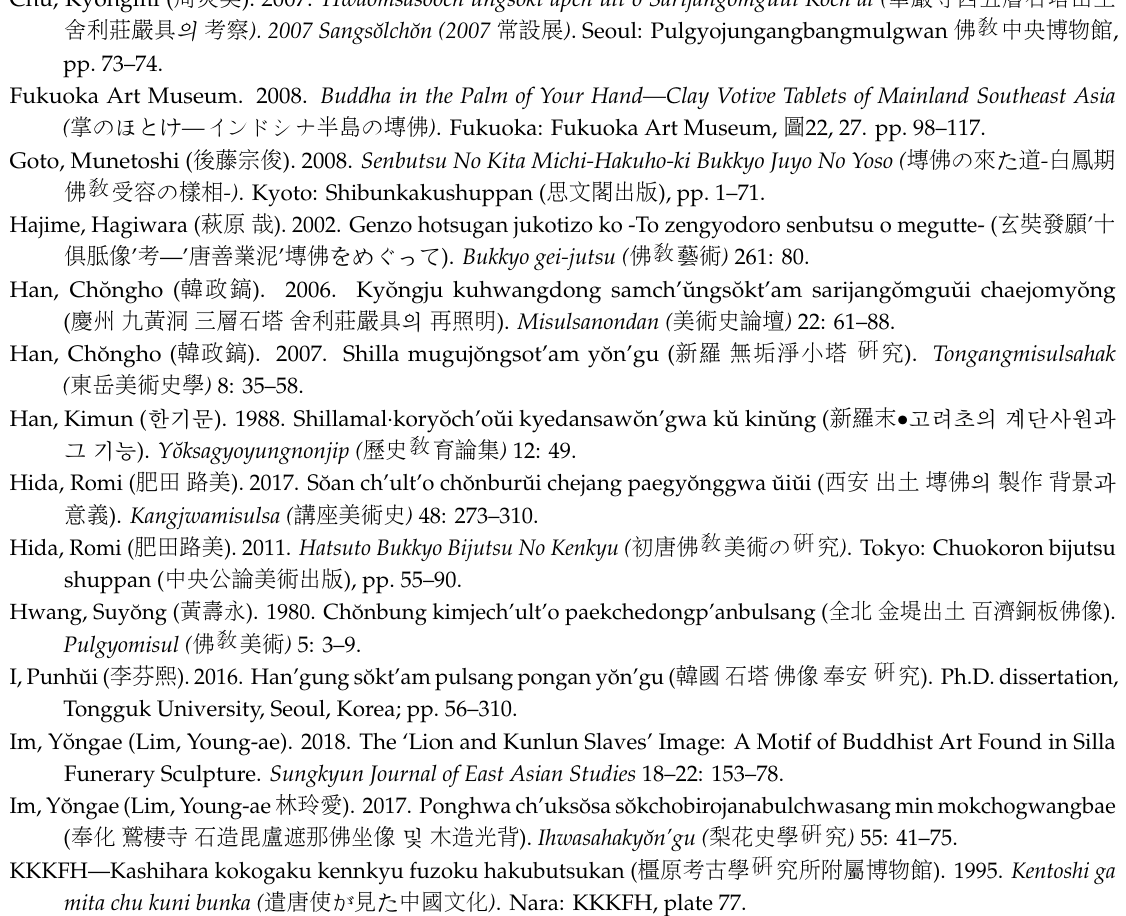
Figure 20. Clay Buddha, Pagan period, 12th–13th centuries, 9.6 × 7.1 cm, Myanmar [Source: (Fukuoka Art Museum 2008, cover picture)].